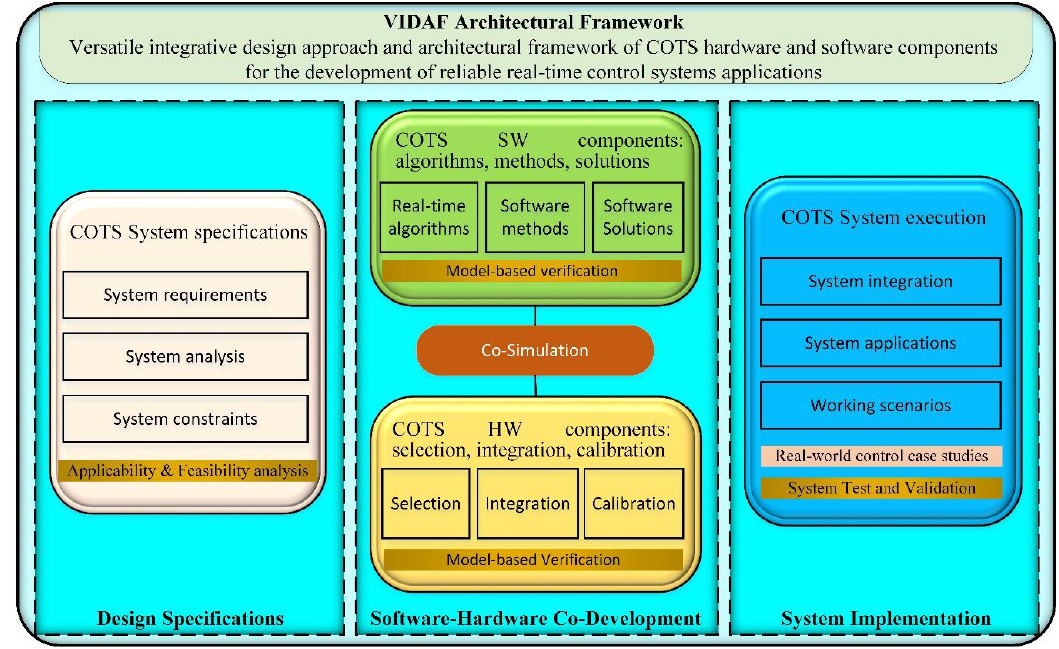
Figure 1. Versatile integrative design approach and architectural framework (VIDAF).